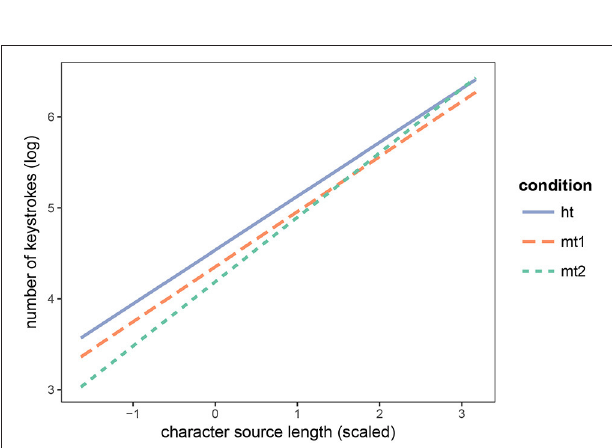
FIGURE 5 | Interaction between the length of the source sentence and the translation condition on technical